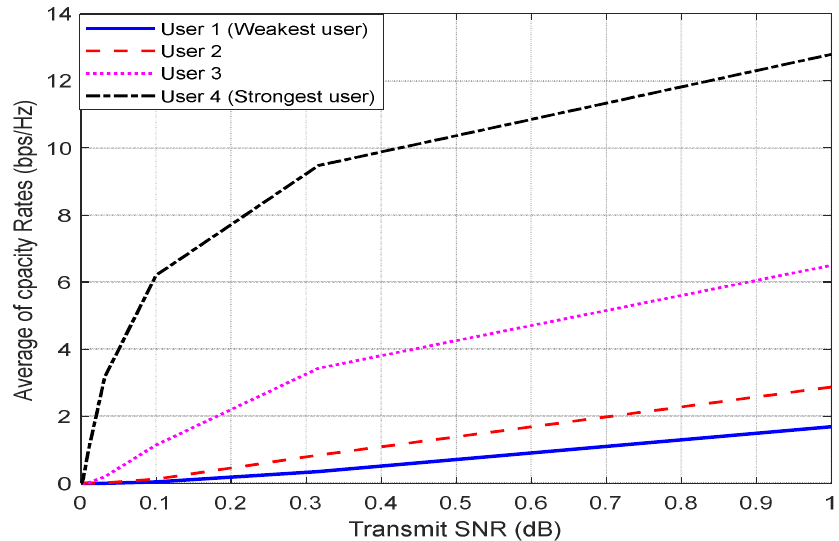
Figure 14. Average capacity rate against SNR for four users with varying distances, with 64 × 64 MIMO and BW 200 MHz for UL NOMA.